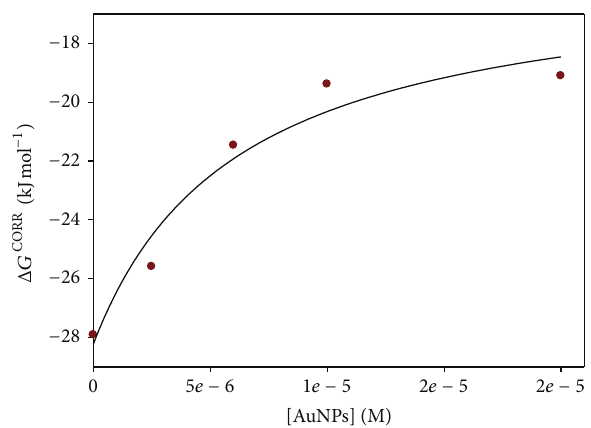
Figure 7: Corrected free energy of 1-PyCHO/AuNPs interaction, Δ𝐺 CORR , versus [AuNPs], best fit to